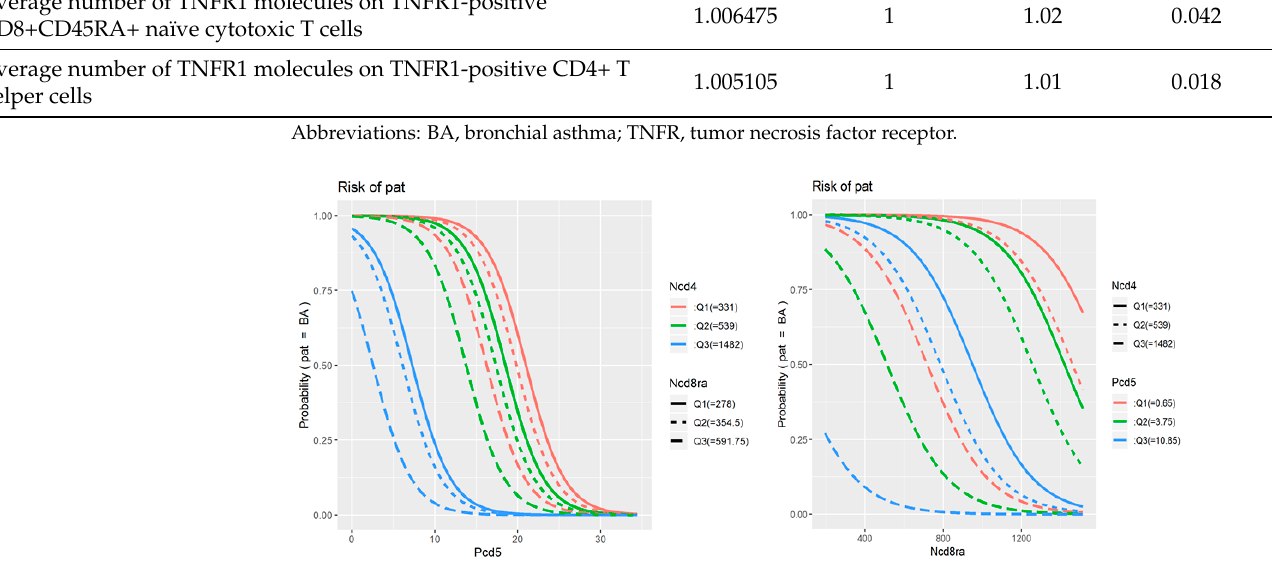
Figure 3. Probability of BA accessed in multivariate logistic regression analysis depending on achieved threshold levels on each of 3 parameters. Ncd4 indicates average number of TNFR1 molecules on TNFR1-positive CD4+ Т helper cells; Ncd8ra indicates average number of TNFR1 molecules on TNFR1-positive CD8+CD45RA+ naïve cytotoxic T cells; Pcd5 indicates percentage of double-positive cells among CD19+CD5+ B cells. Q1, Q2, Q3 indicate three threshold levels on each of the